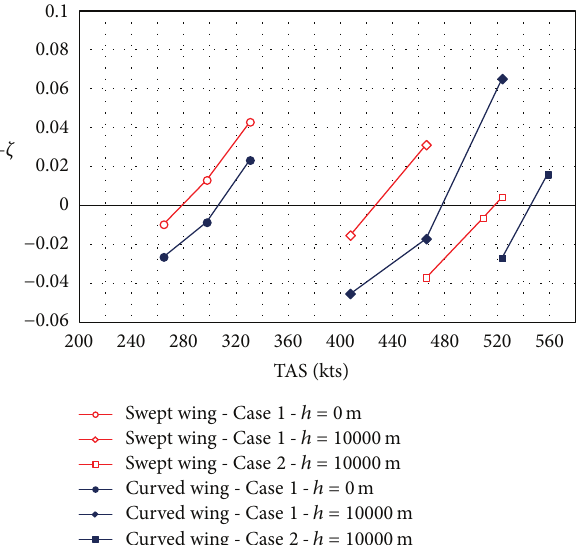
Figure 16: Damping ratio versus True Air Speed (the damping data are represented with the opposite